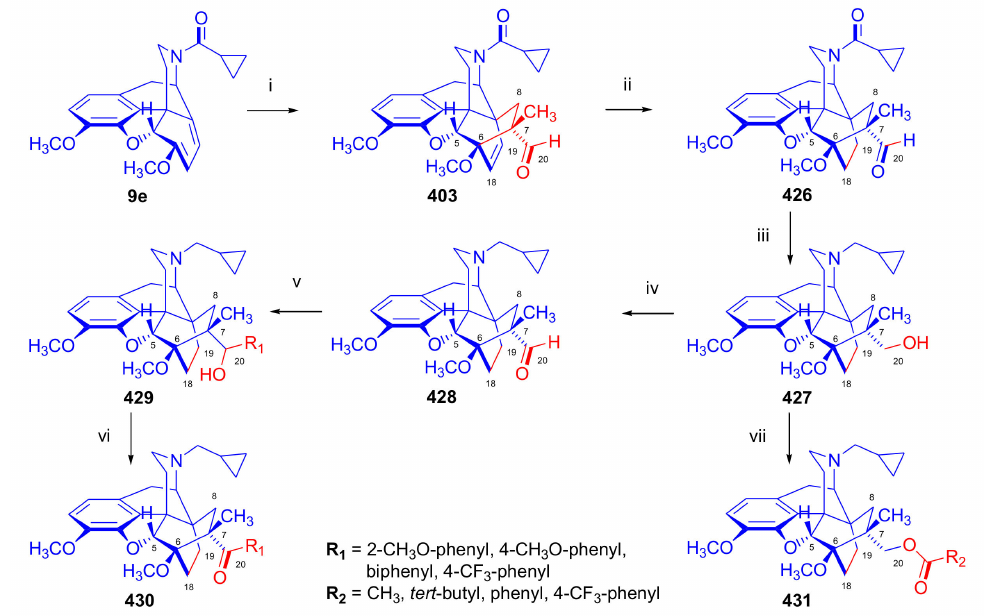
Figure 107. Synthesis of N 17 -cyclopropylmethyl-nornepenthone derivatives. Reagents and conditions